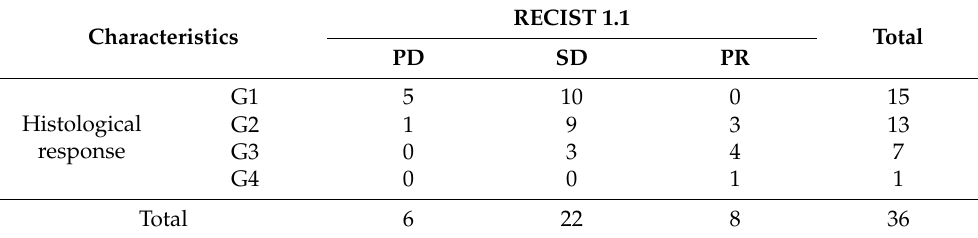
Table 2. Relationship between the histological response and changes in the main lesion (based on RECIST